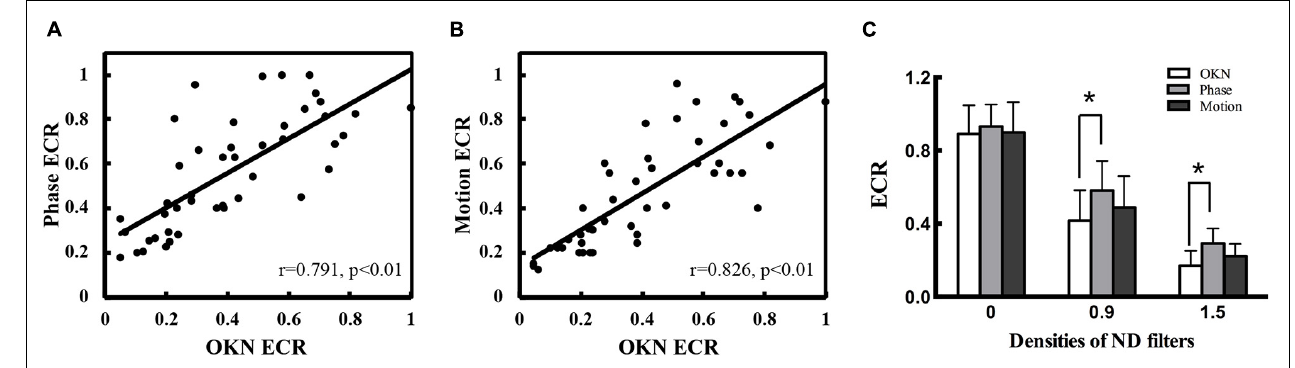
FIGURE 3 | Comparison of the dOKN test with phase and motion tests in control subjects. (A) The visual suppression results of the dOKN test were positively correlated with that of the phase test. (B) The visual suppression results of the dOKN test were positively correlated with that of the motion test. (C) The visual suppression measured the dOKN test as well as the phase and motion tests in normal subjects under various ND filters. Deep visual suppression was induced in normal subjects under the 1.5 D filter. *Represented statistical difference.